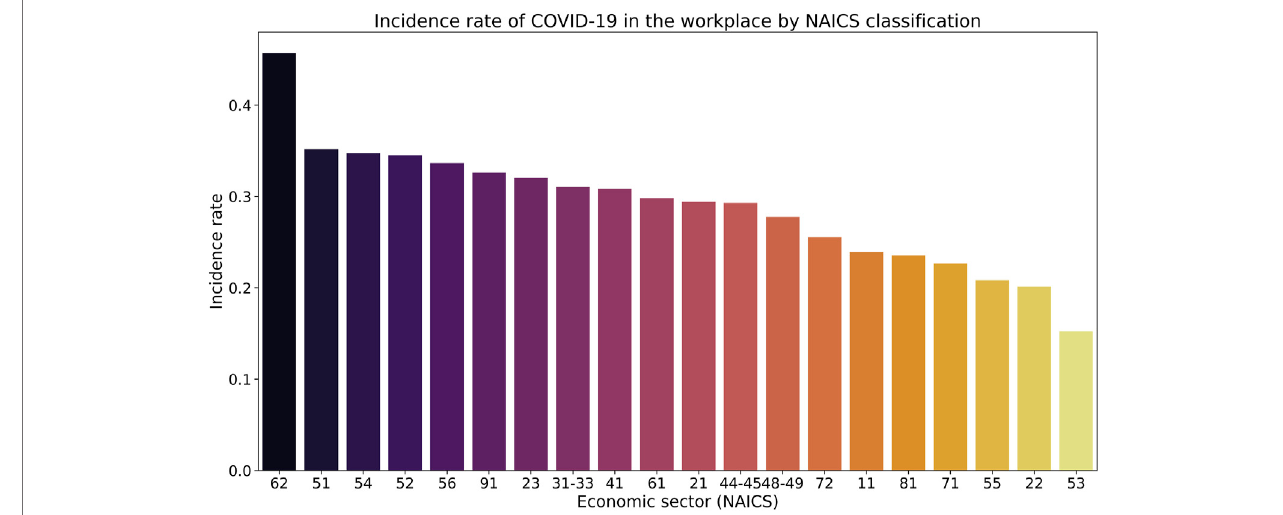
FIGURE 8 | Incidence rate of COVID-19 in the workplace by NAICS classi fi cation.